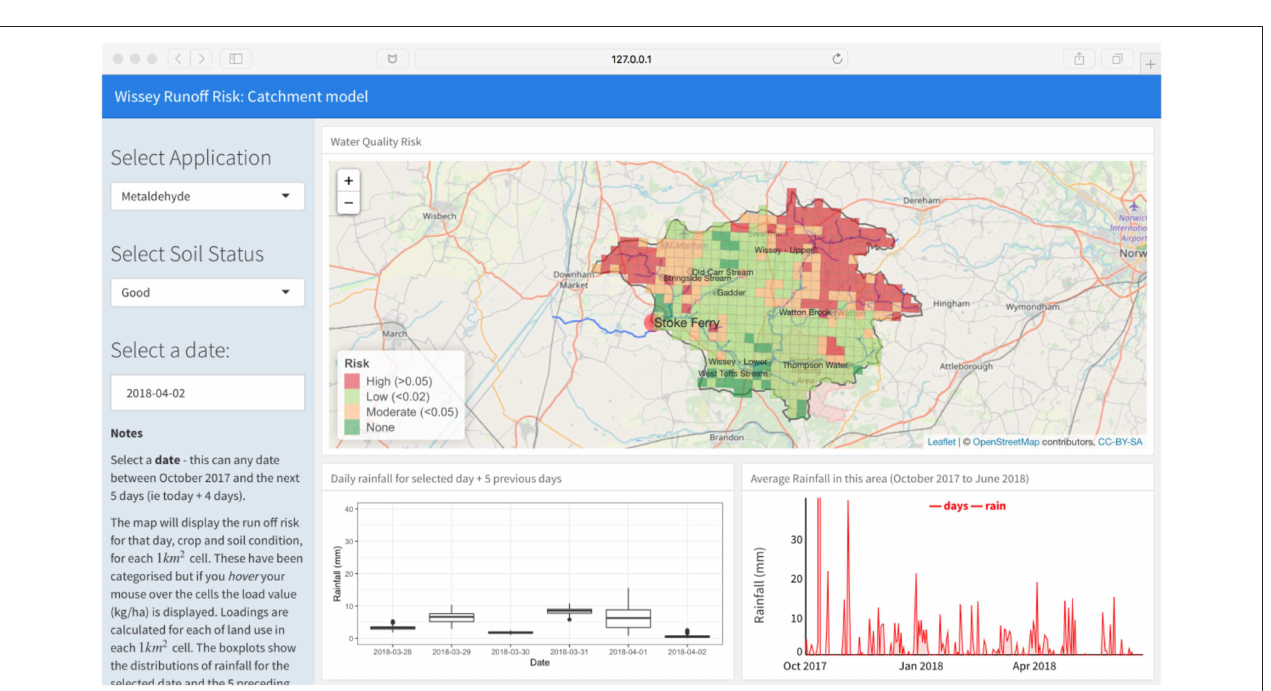
FIGURE 4 | A screenshot of output from the Wissey catchment scale field-to-channel delivery risk model at